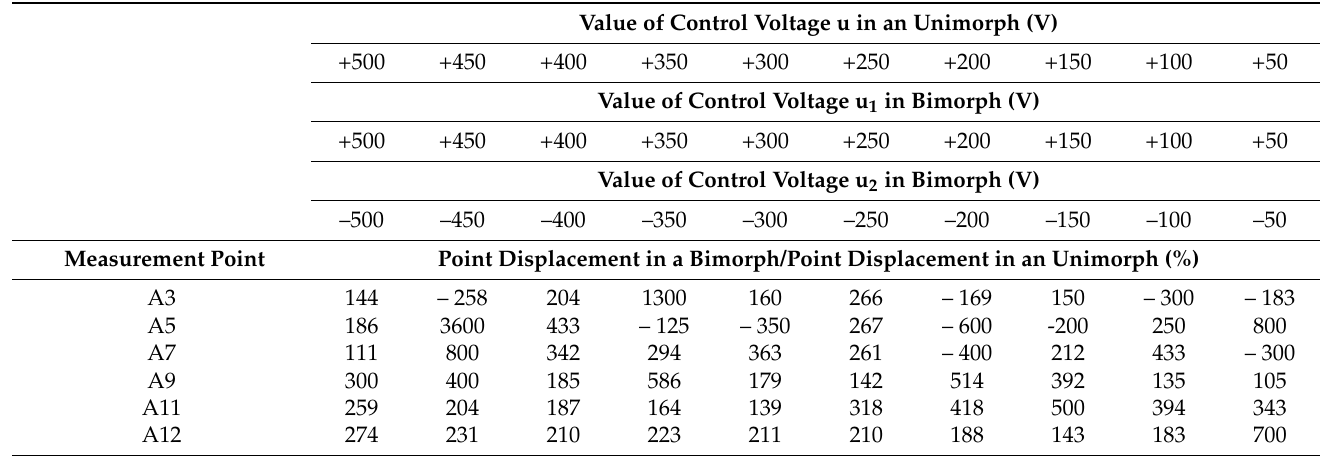
Table 4. Comparison of a percentage ratio of point displacements in the bimorph and in the